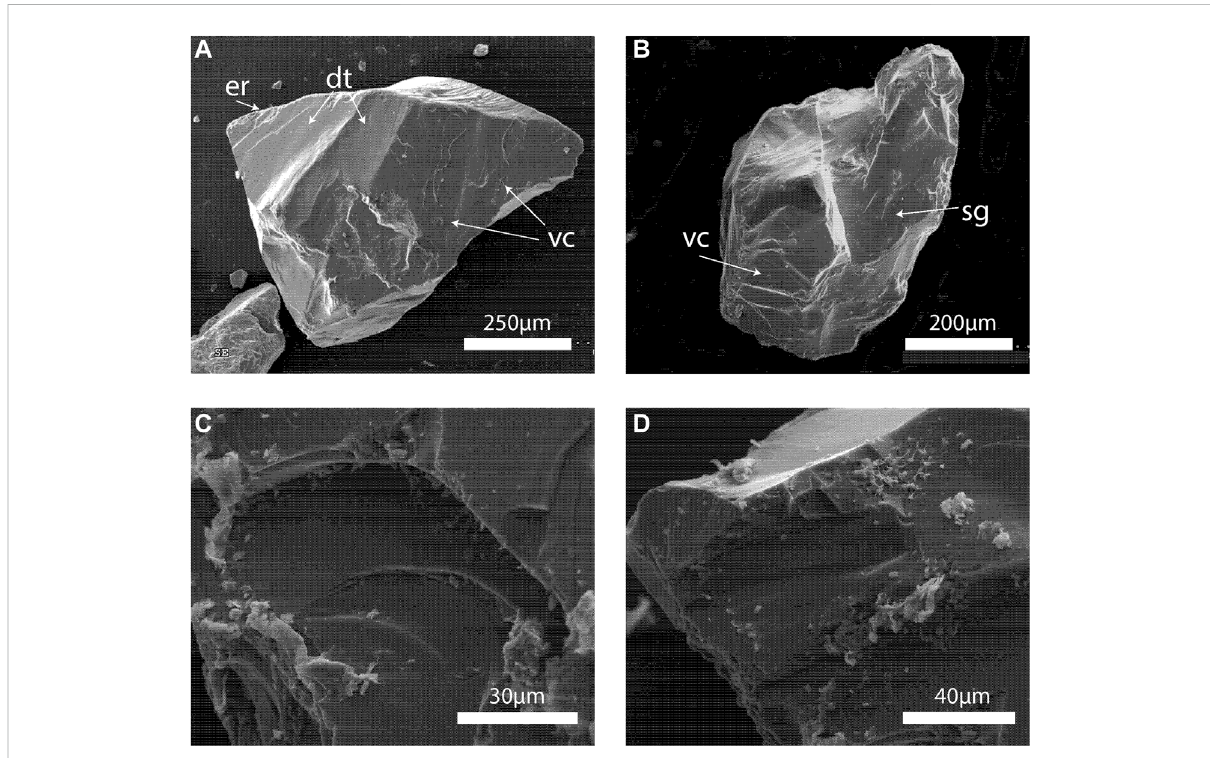
FIGURE 1 SEM micrographs demonstrating the character and preservation of glacial in fl uence on grain transport. (A,B) grains collected in modern fl uvial system, 65 km down the Chitina River from the terminal moraine of the Chitina Glacier (AK, United States; see Sweet and Brannan, 2016). (A) Undulose surface on quartz grain with grooves > 10 µm deep, termed deep troughs (dt). Grain has experienced percussion overprinting due to saltation during fl uvial transport as indicated by edge rounding (er) and v-shaped cracks (vc). (B) Linear groove < 10 µm deep on the fracture surface, termed straight grooves (sg). Percussion in fl uence on grain is demonstrated by abundant chipping at grain edges that manifest as arcuate steps and conchoidal fractures as well as numerous v-shaped cracks (vc). Note only one v-shaped crack is identi fi ed in the micrograph, but numerous occurrences are present. (C,D) grains collected in Permo-Pennsylvanian Cutler Formation (interpreted proglacial fl uvial system; see Keiser et al., 2015)showing microtexturesincluding conchoidalfractures (C) and linear grooves ( < 10 µmdeep). See Sweet and Soreghan (2010b) for classi fi cations of transport-induced microtextures on quartz grain